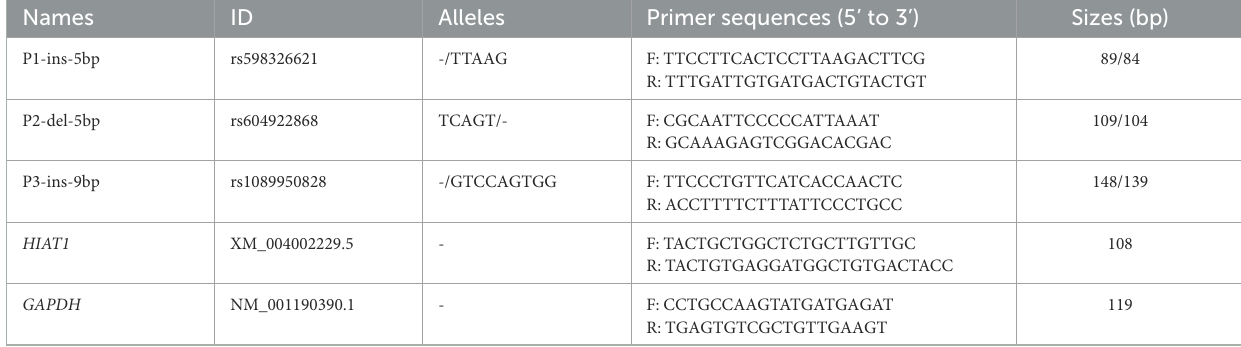
TABLE 1 Primers used for InDel detection and qPCR analysis of ovine HIAT1